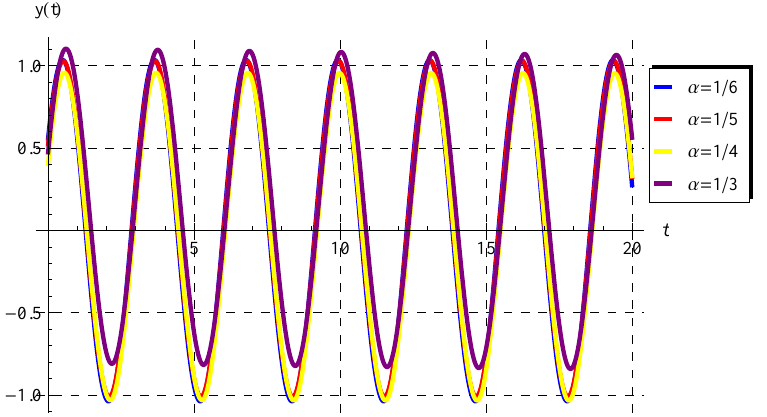
Figure 1. Graphs of the solution (47) at a = 1, b = 1, A = 2, ω = 1